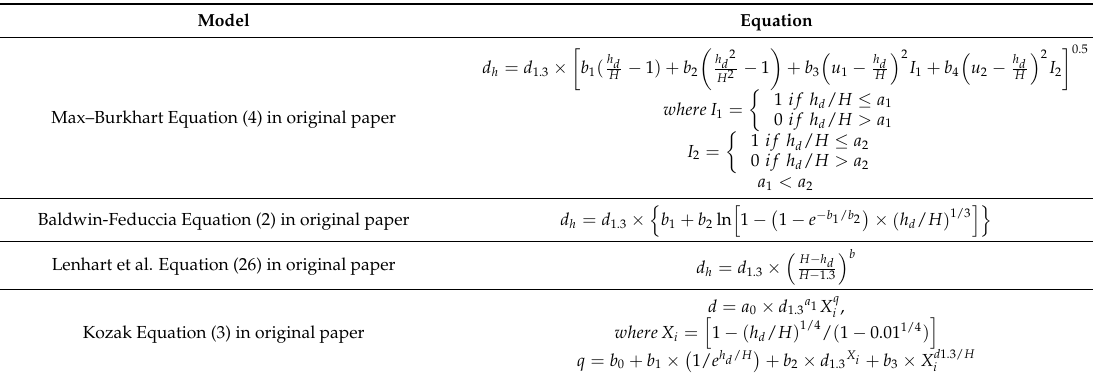
Table 2. Taper equations used for modeling diameter outside